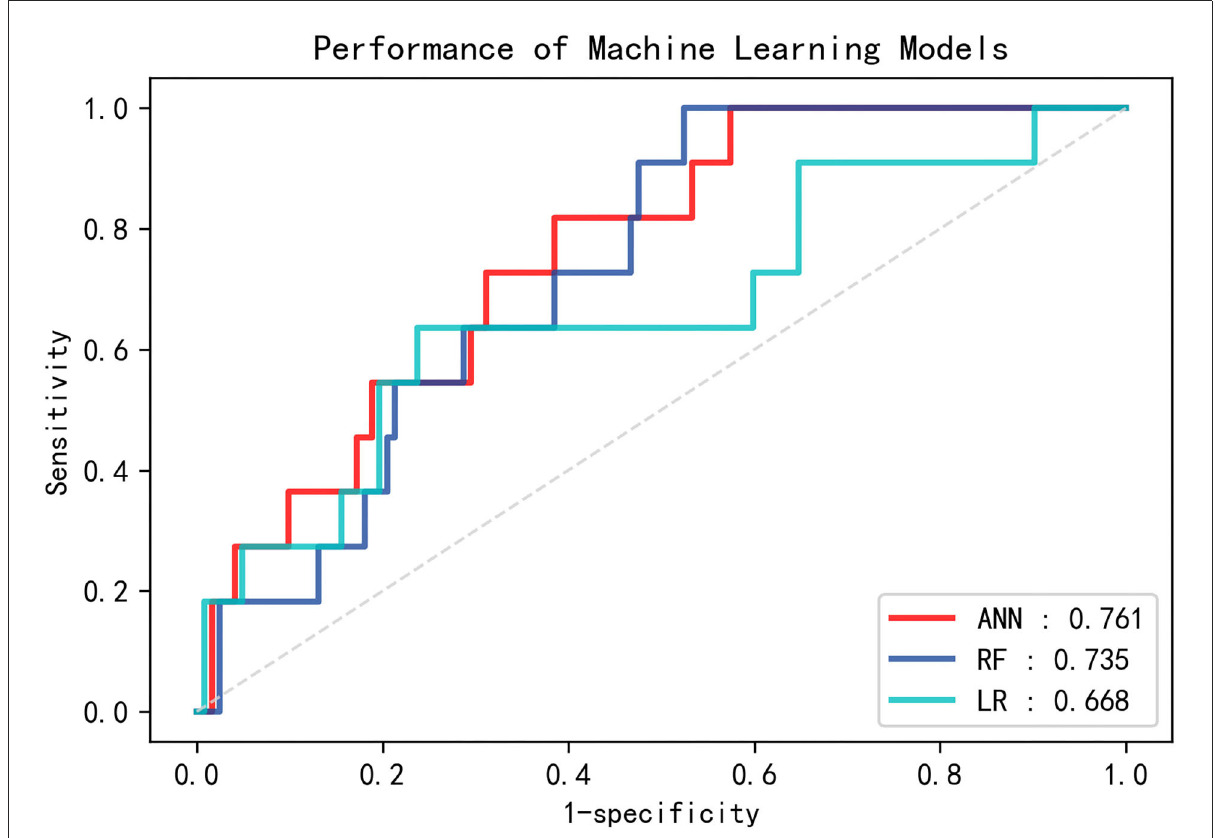
FIGURE1 Receiver operating characteristic (ROC) curves for the three machine learning models (ANN, RF, and LR) on the testing set. ANN, artificial neural network; RF, random forest; LR, logistic regression.